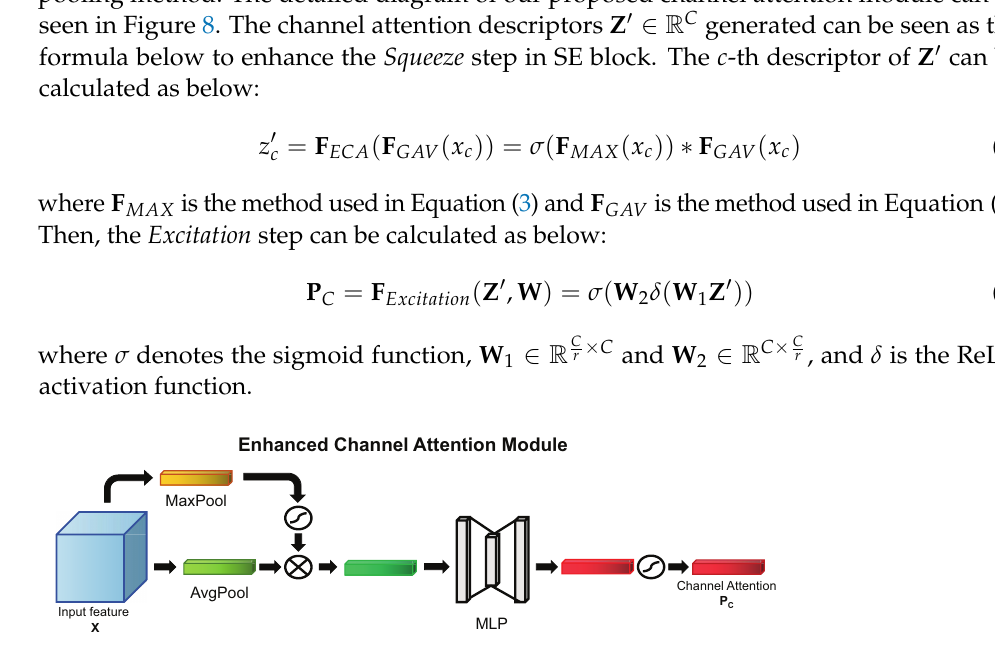
Figure 8. The proposed channel attention mechanism of